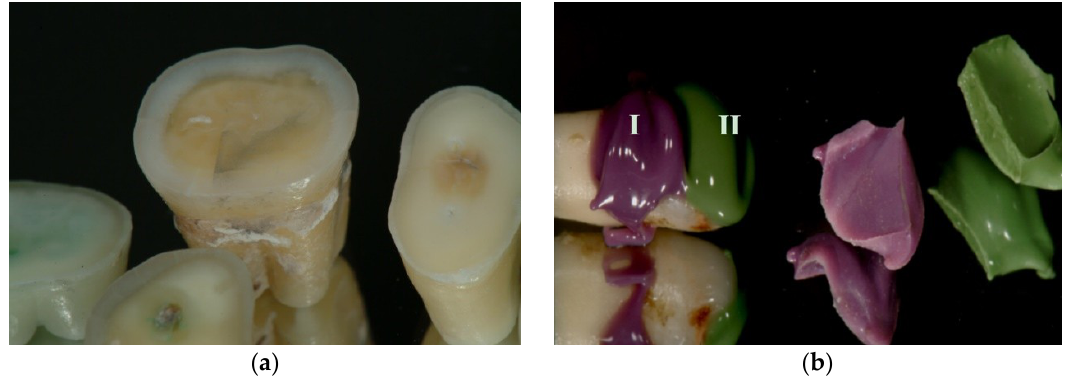
Figure 1. Image showing di ff erent teeth during preparation. ( a ) Teeth with exposed dentin, before immediate dentin sealing (IDS) treatment; ( b ) the same tooth sample, after IDS, which was impressed with polyether (I) and silicone